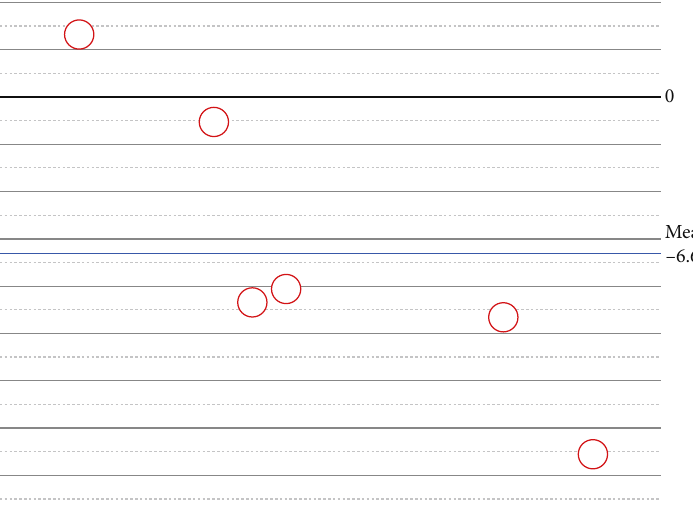
Figure 3: Omission and correct identi fi cation of mental memory.